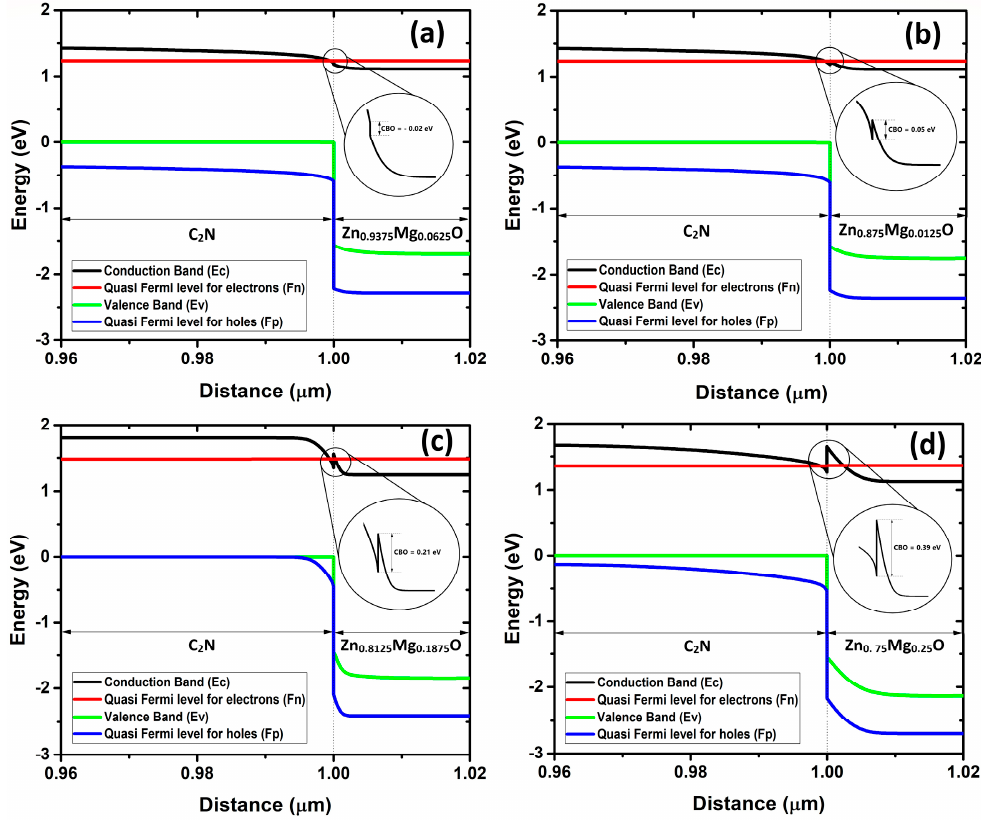
Figure 3 . ( a – d ) Energy band alignment at the C 2 N/ZMO interfaces . Figure 3. ( a – d ) Energy band alignment at the C 2 N/ZMO